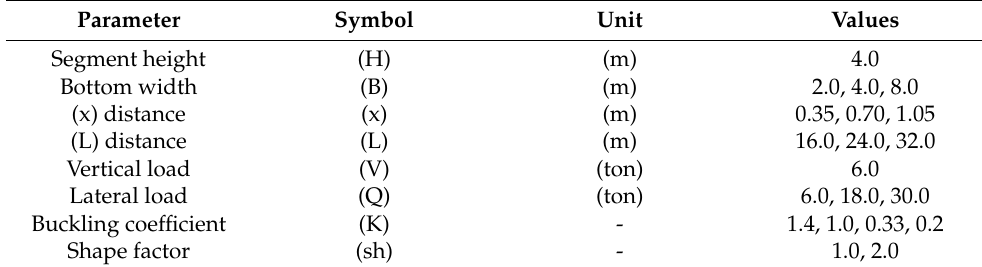
Table 1. Value ranges of the parametric study.